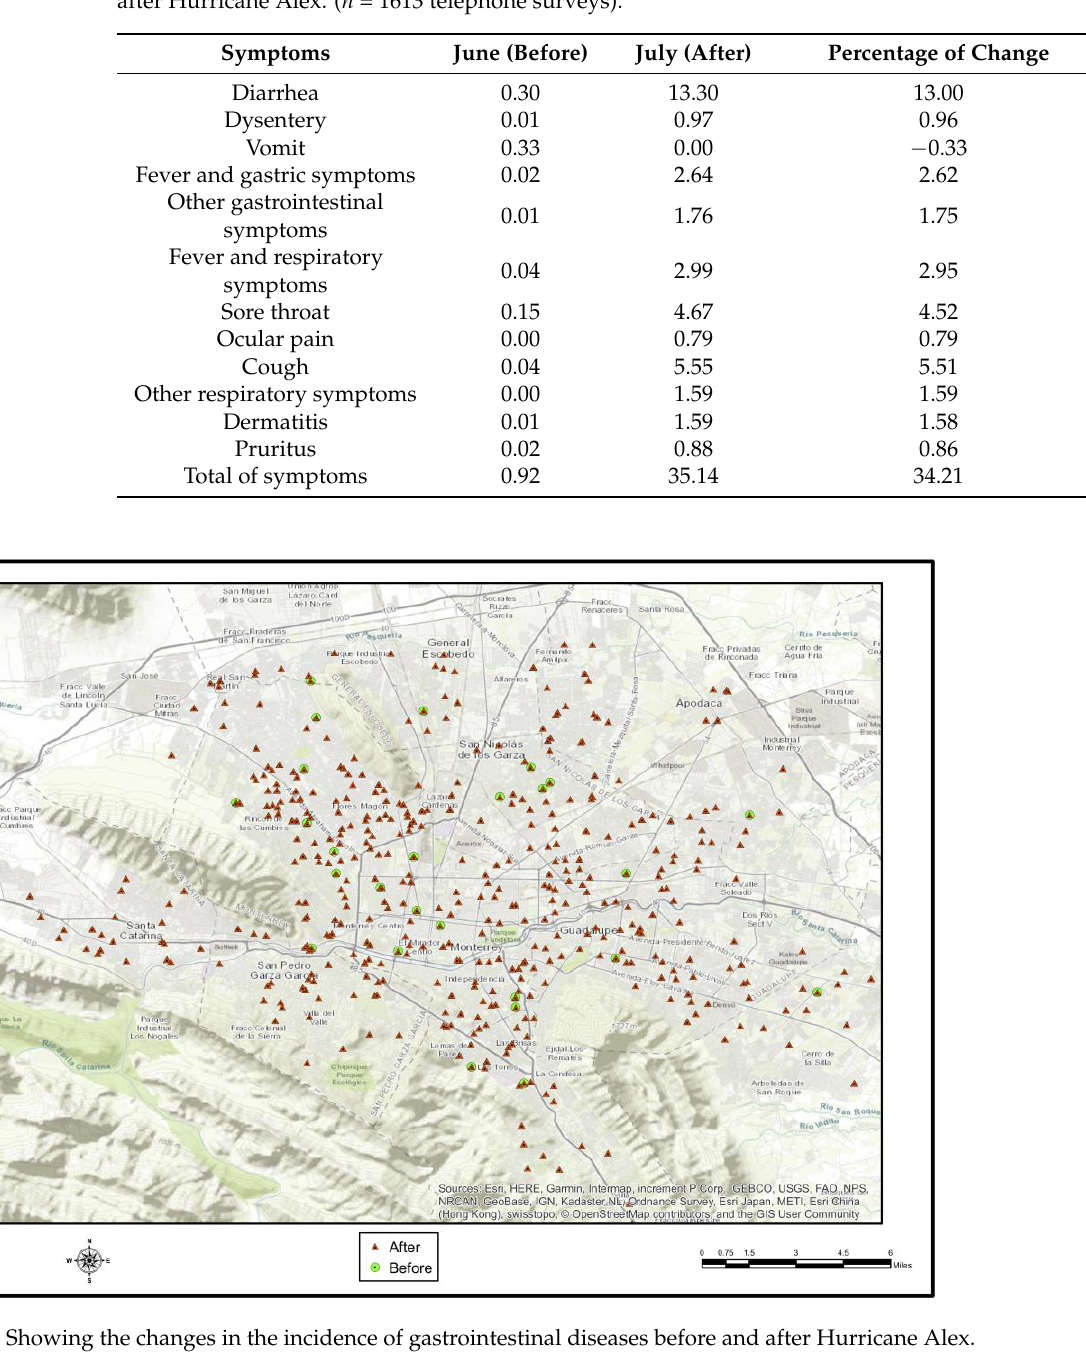
Figure 6. Showing the changes in the incidence of gastrointestinal diseases before and after Hurricane Alex.